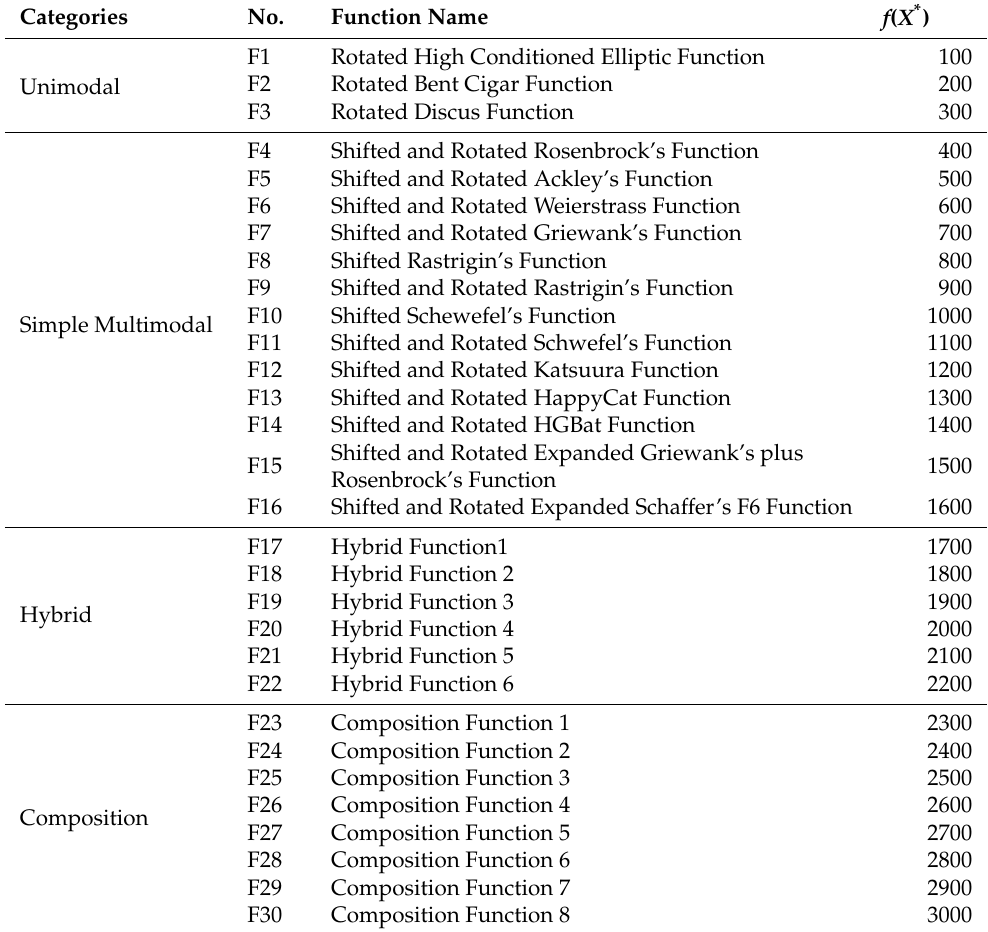
Table 3. CEC 2014 benchmark functions and its fitness value of theoretical global